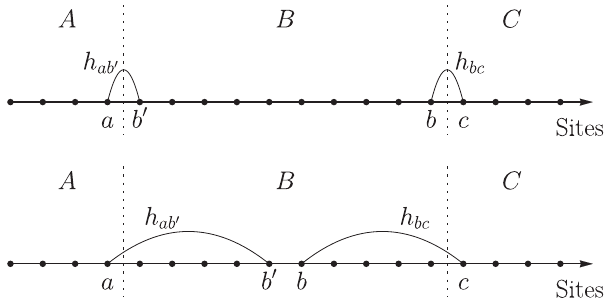
FIG. 6. An illustration of h and h in a one-dimensional ab 0 bc lattice. For short-range interactions, the sets f a; b 0 g and f b; c g are separated by a distance of the same order as the size of B (upper panel). The contributions from these terms to δ are bounded overlap using a Lieb-Robinson bound. However, for long-range inter- actions, f a; b 0 g and f b; c g can be geometrically close to each other (lower panel). In such cases, the norms of h and h ab 0 bc decay as j b 0 − a j − α and j c − b j − α and, therefore, their contribu- tions to δ are overlap